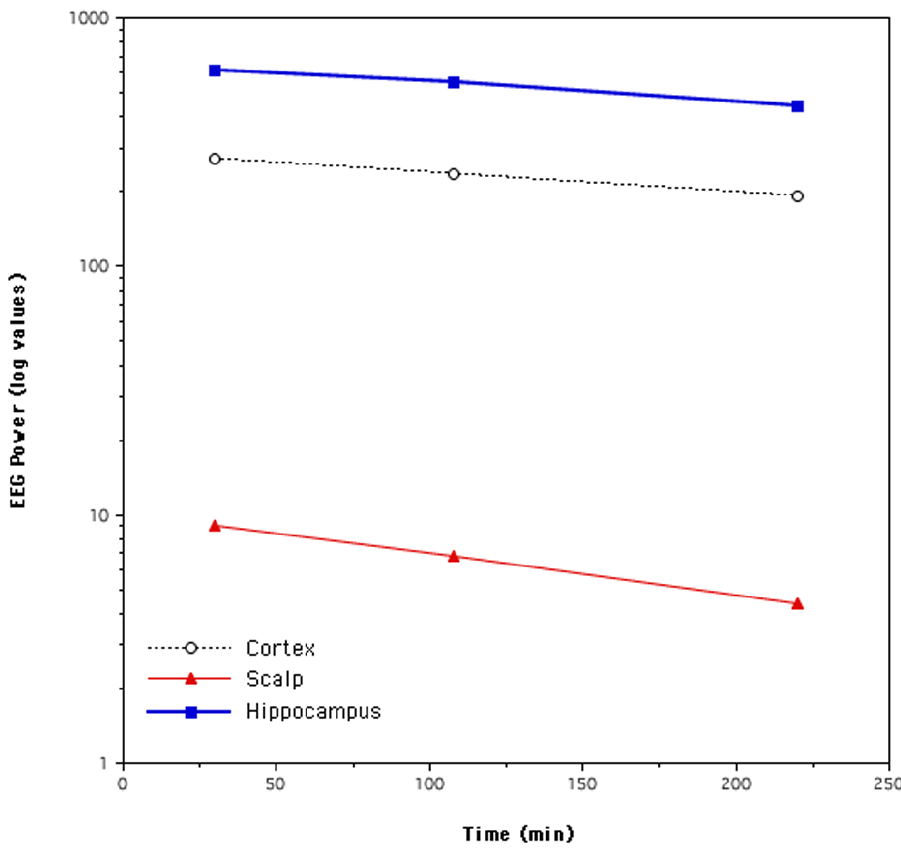
Figure 6. Linear decrease of delta power (1.1–5.0 Hz) across the first three sleep cycles in the cortical, hippocampal and scalp recordings. Values are expressed in a logarithmic scale.